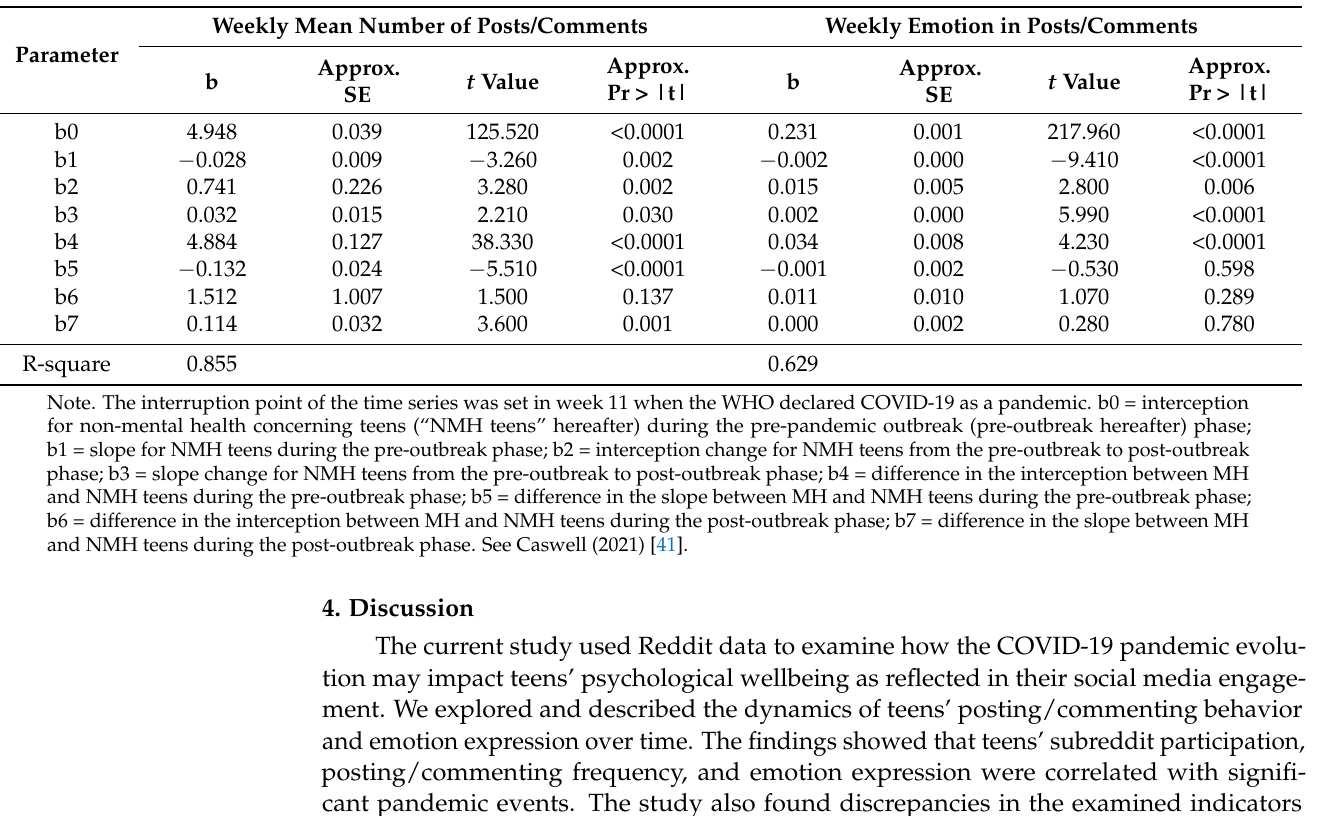
Table 2. Multi-group Interrupted Time Series Analyses of posting and emotions on r/Teenagers by comparing teens with and without mental health